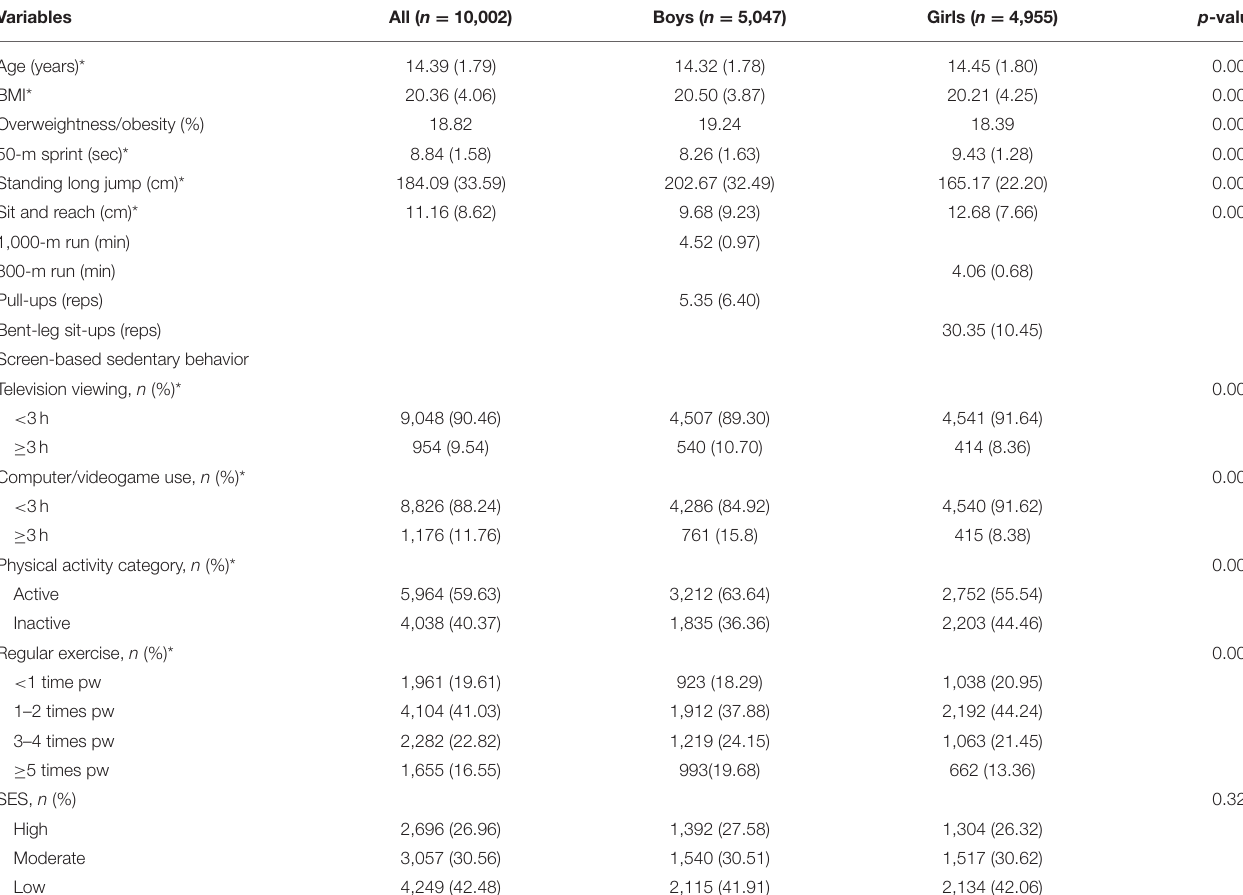
TABLE 1 | Characteristics of